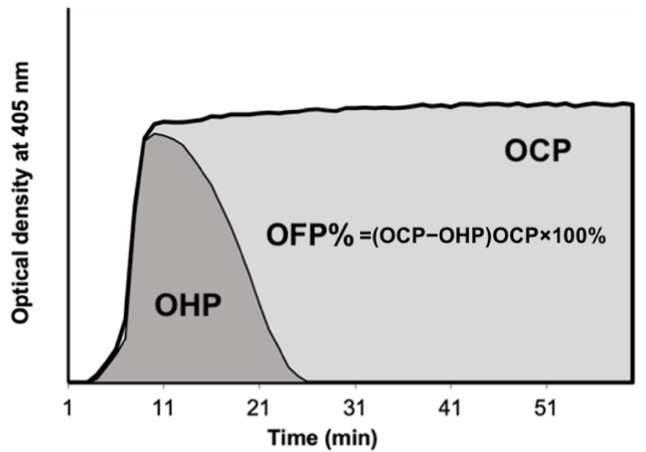
Figure 1. Overall Hemostatic Potential (OHP) assay. OCP is the area under the curve (AUC) of the OD curve obtained by the addition of thrombin (0.006 IU/mL) with CaCl 2 . OHP is the AUC of the curve by adding thrombin (0.006 IU/mL), CaCl 2 and tPA. The OFP% is the difference between the AUCs OCP and OHP. Abbreviations: OCP overall coagulation potential; OHP overall haemostatic potential; OFP% overall fibrinolytic potential.